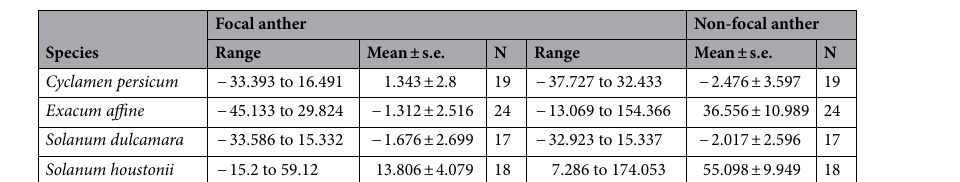
Table 3. Difference in displacement amplitude in µm (Anther D RMS – Forceps D RMS ) between forceps and anther for each anther type and species across samples. Values for the vector are calculated from the x- and y-axes (see “Materials and methods” section for details). N number of